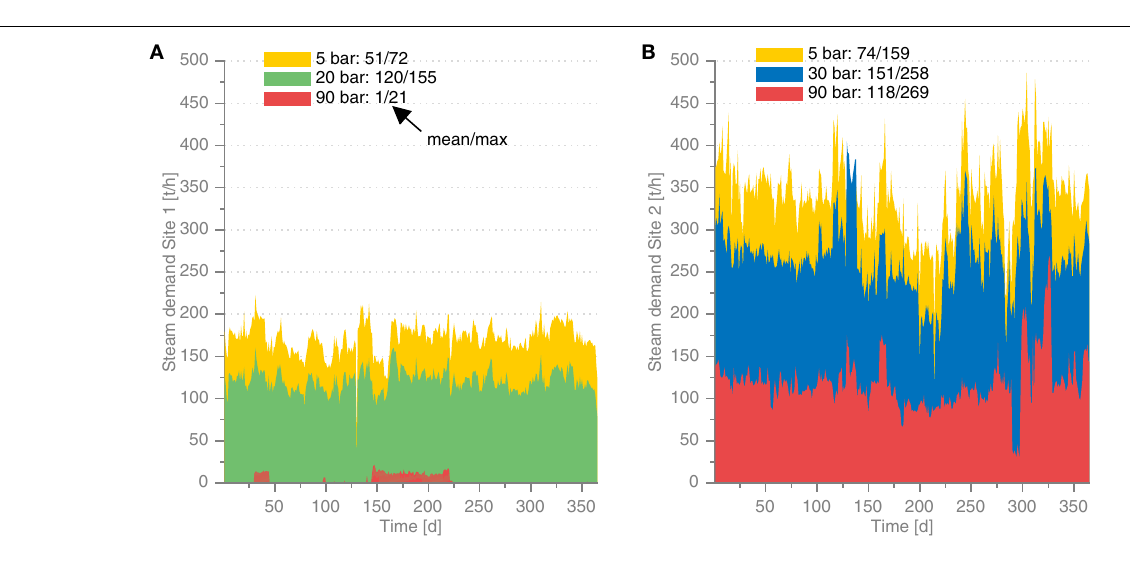
FIGURE 4 | Steam demand of Site 1 (A) and Site 2 (B)